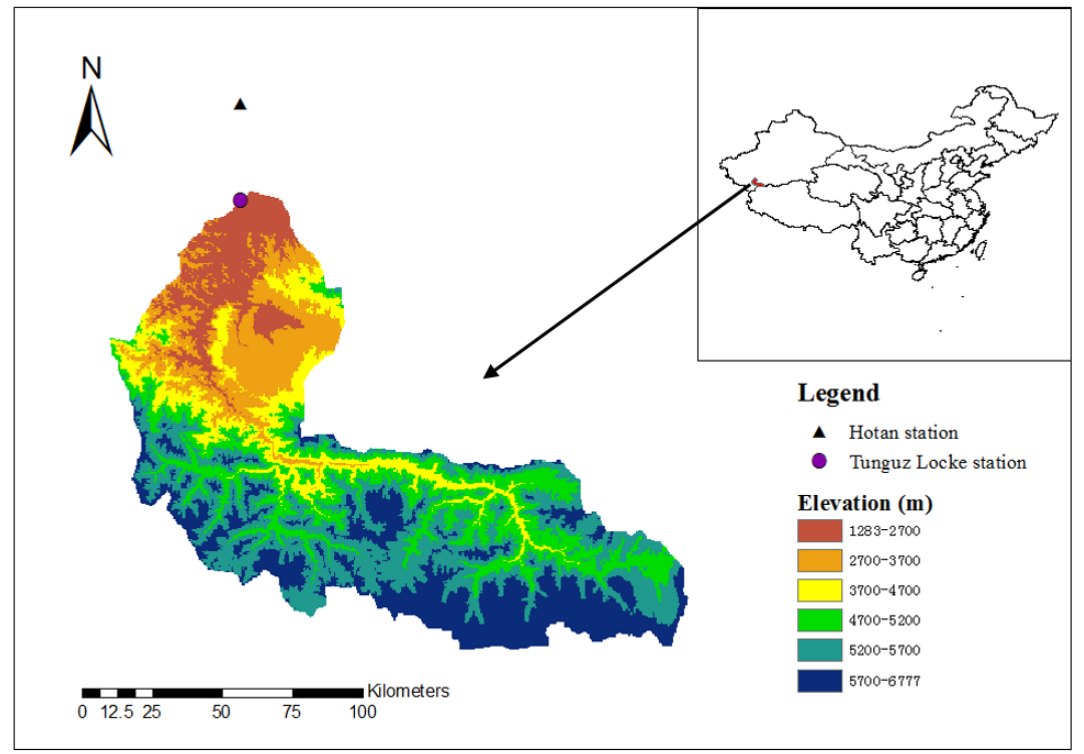
Figure 1. The location and topography of the deglaciating Yurungkash watershed with the meteorological station (Hotan) and the discharge station (Tunguz Locke).